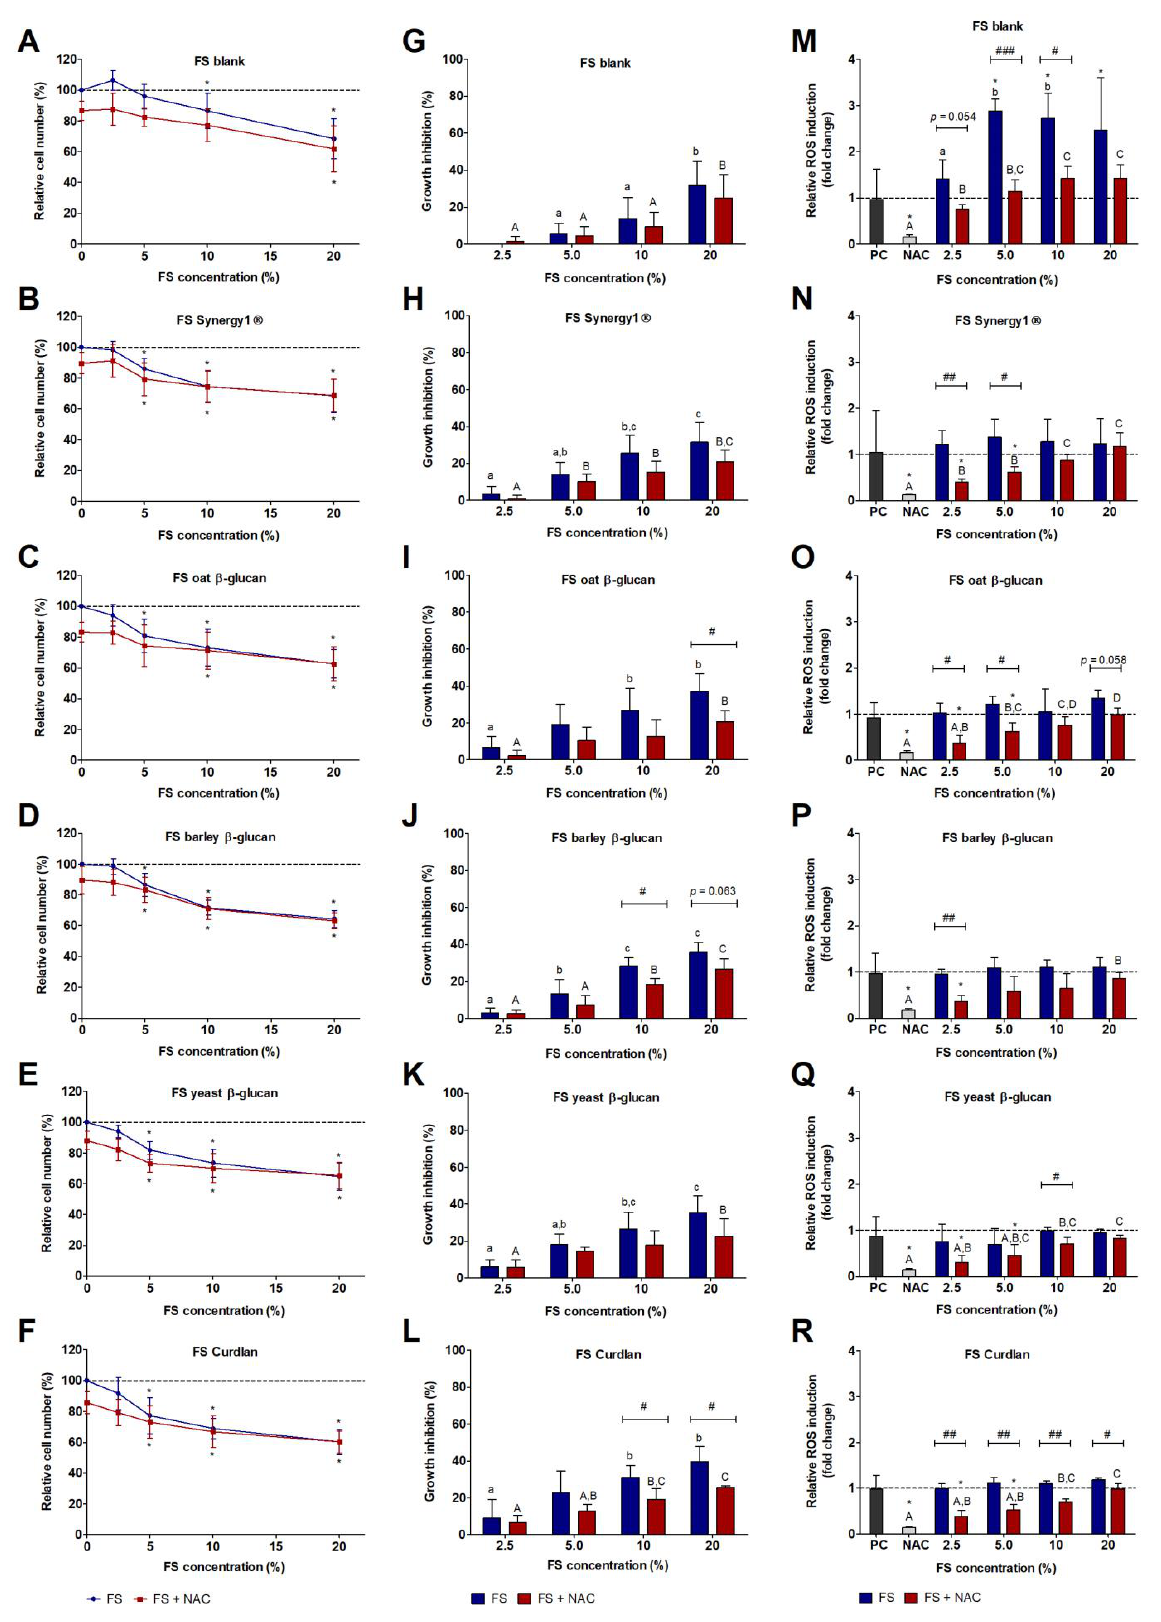
Figure 3. Relative number (%) of HT29 colon carcinoma cells ( A – F ), growth inhibition rate (%) of HT29 cells ( G – L ), and relative ROS induction (fold change) in HT29 cells ( M – R ) after treatment with